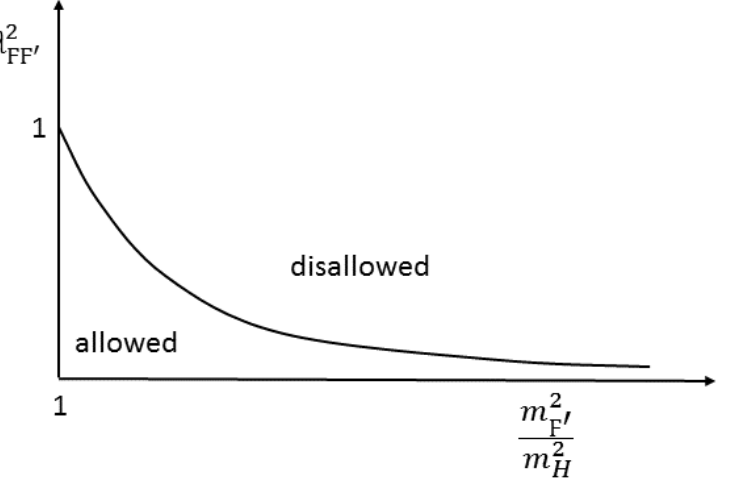
Figure 2. The allowed and disallowed regions for a naturally coupled DS obeying the bound in (43). Here (cid:122) (cid:48) is a typical DS field mentioned in (1)–(3). (taken from Reference [29]). To elucidate the meaning and effects of the naturally coupled DS; it proves conve- nient to study its certain salient features. The first point to study would be naturalness condition (43) under the renormalization group flow of the model parameters. This is important because the Higgs boson mass mast be kept stable under the logarithmic contri- butions in (44). Depicted in Figure 3 are the scale dependencies of the Higgs boson mass from the electroweak scale up to the GUT scale in the SM (black curve) and in the SM + DS (red curve). In here, the DS is represented by a singlet scalar H (cid:48) such that SM–DS coupling obeys the seesawic bound in (43) at the GUT scale. It thus follows that naturally coupled dark sectors do indeed not disrupt the stability of the electroweak scale